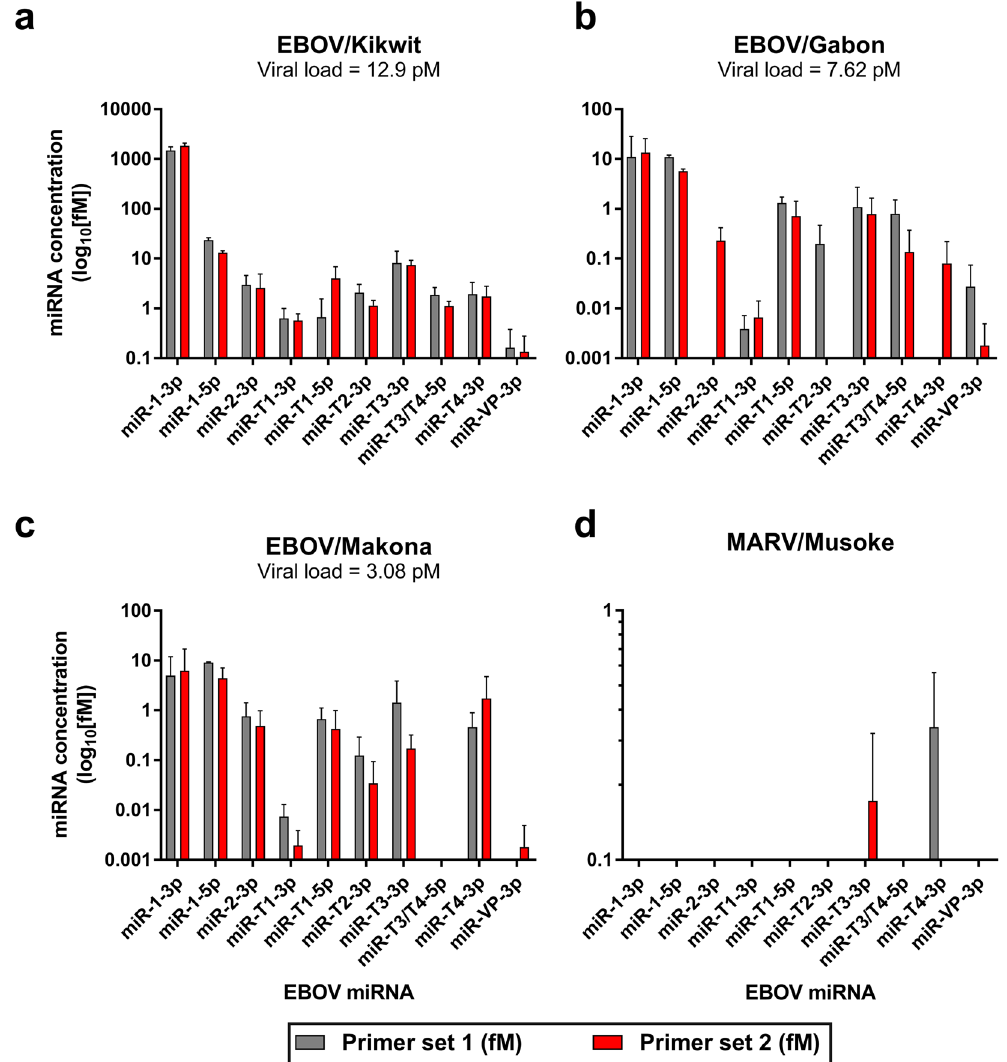
Figure 2. EBOV-encoded miRNAs are present in cell culture supernatants from different EBOV variants. Cell culture supernatant RNA from 10 6 PFU/mL of ( a ) EBOV/Kikwit, ( b ) EBOV/Gabon, ( c ) EBOV/Makona, and ( d ) MARV/Musoke viral stocks were tested for candidate EBOV miRNAs. Data are presented as the mean ± SD of technical triplicates. EBOV viral concentration was determined by RT-qPCR of a glycoprotein sequence and miRNAs were assayed using custom LNA-based primer sets from Exiqon, Inc. following manufacturer’s protocols. Each putative miRNA was tested with the top two primer sets from the manufacturer’s web design